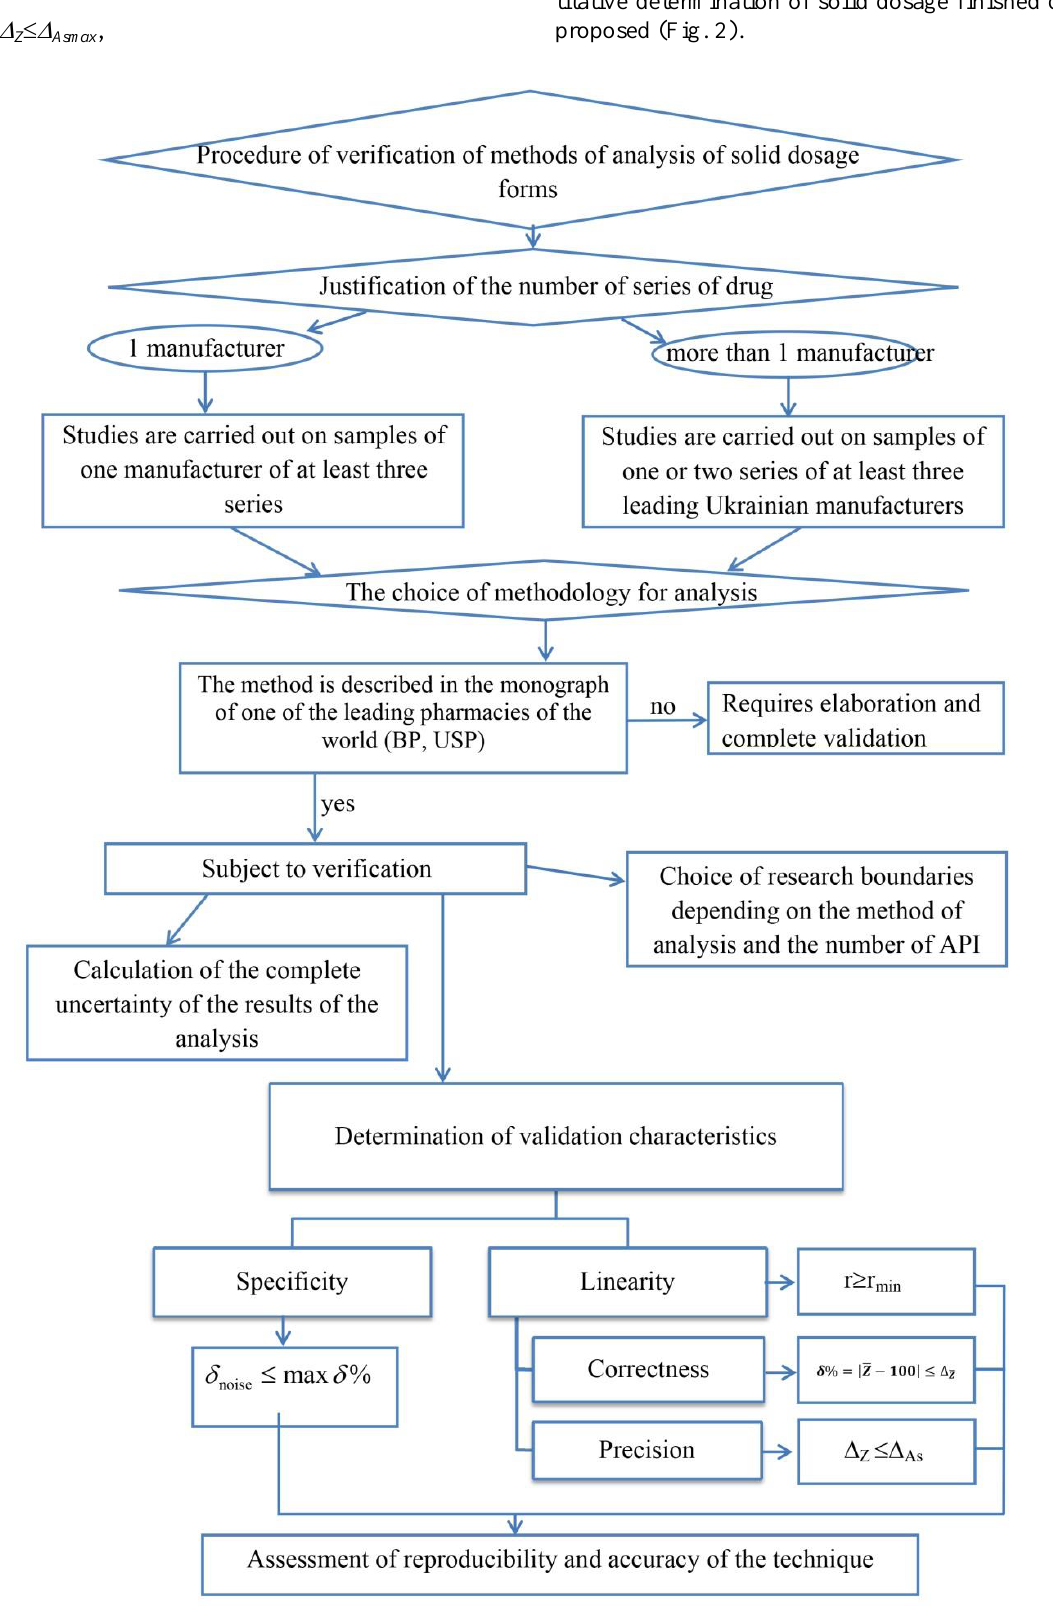
Fig. 2. Procedure for verification of methods for quantitative determination of finished drug products in accordance with the requirements of the 2nd edition of the State Pharmacopoeia of